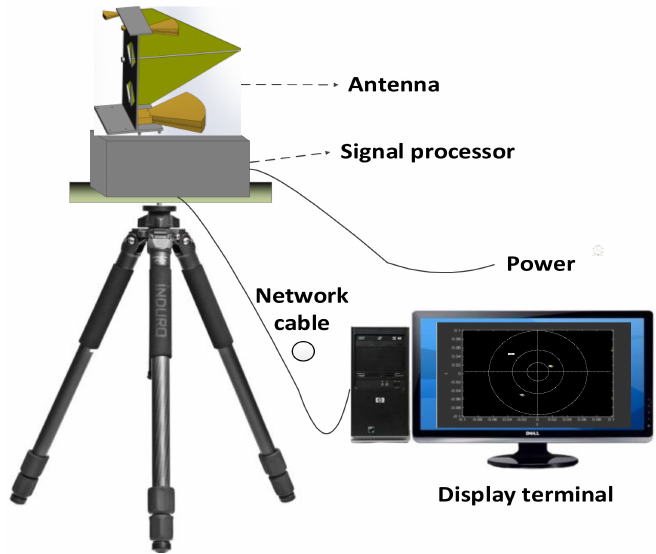
Figure 9. Schematic diagram of the signal reconnaissance